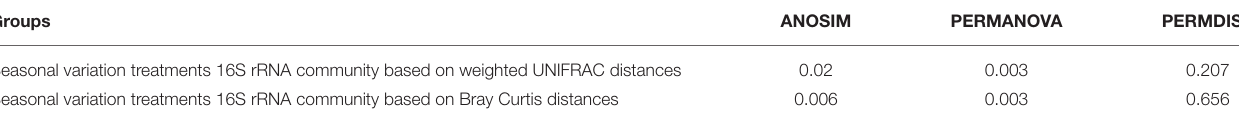
TABLE 2 | Comparison of 16S rRNA community seasonal variation using three statistical methods ( p -value).